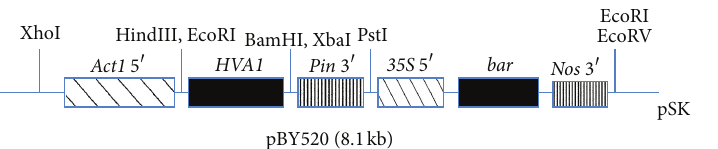
Figure 1: The linear map of pBY520 construct. Rice actin promoter ( Act1 ), barley ( Hordeum vulgare ) or HVA1 LEA3 gene, cauliflower mosaic virus 35S ( 35S ) promoter, bar Liberty herbicide resistance gene ( bar ), and nopaline synthase terminator ( Nos 3 󸀠